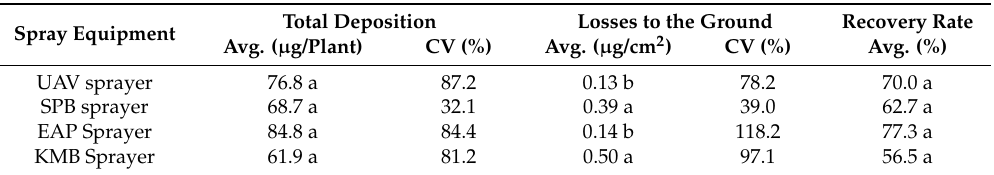
Table 1. The average (Avg.) and coefficient of variation (CV) of the total deposition on the plants, losses to the ground and the recovery rate of four